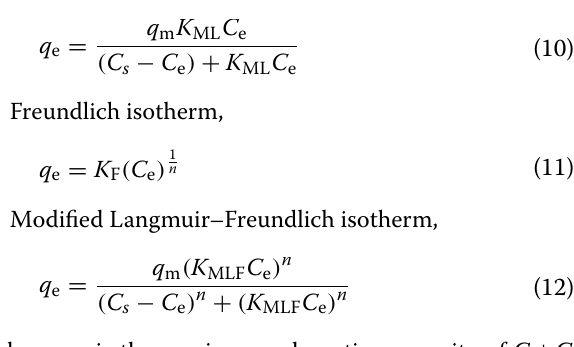
Table 3 Parameters of isotherm models obtained using CV at 298 K for adsorption of Cr(VI) on C Isotherm